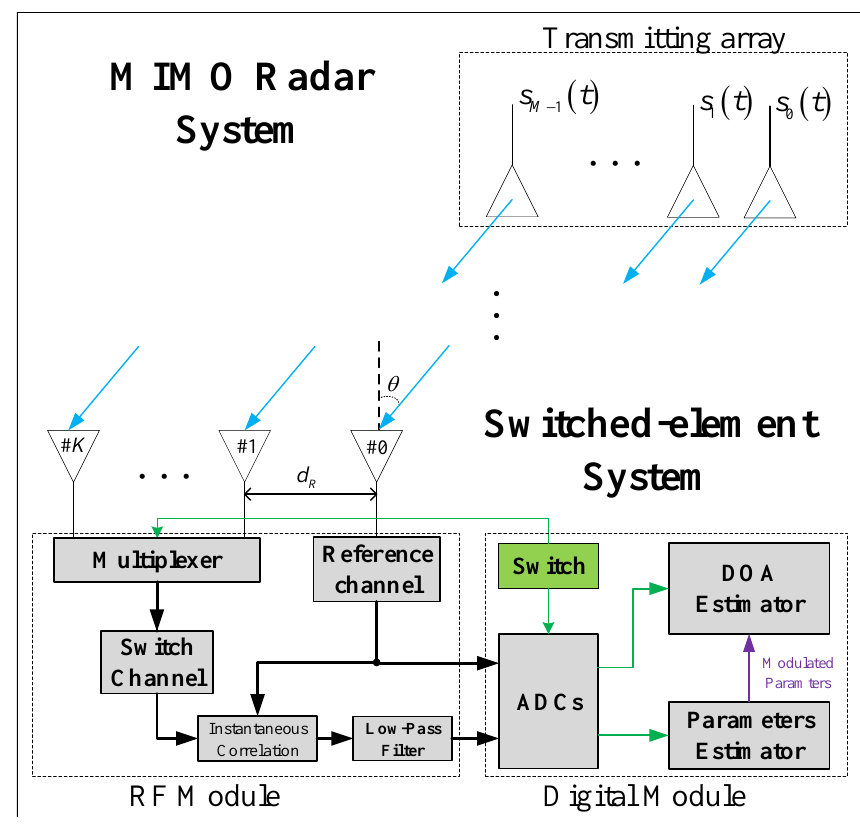
Figure 1. Block diagram of the Switched-Element Direction Finding System (RF is short for the Radio Frequency, ADCs is short for Analog to Digital converters) and Multiple-input multiple-output radar